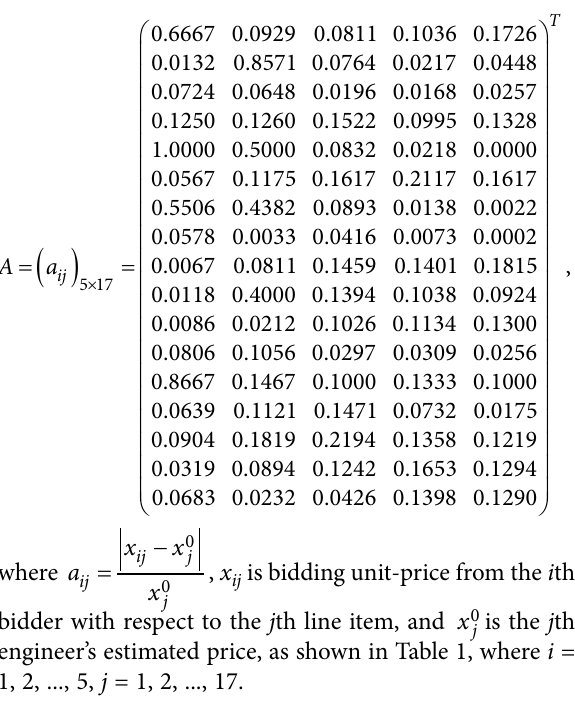
Figure 1. The framework of VIKOR model for identification of unbalanced